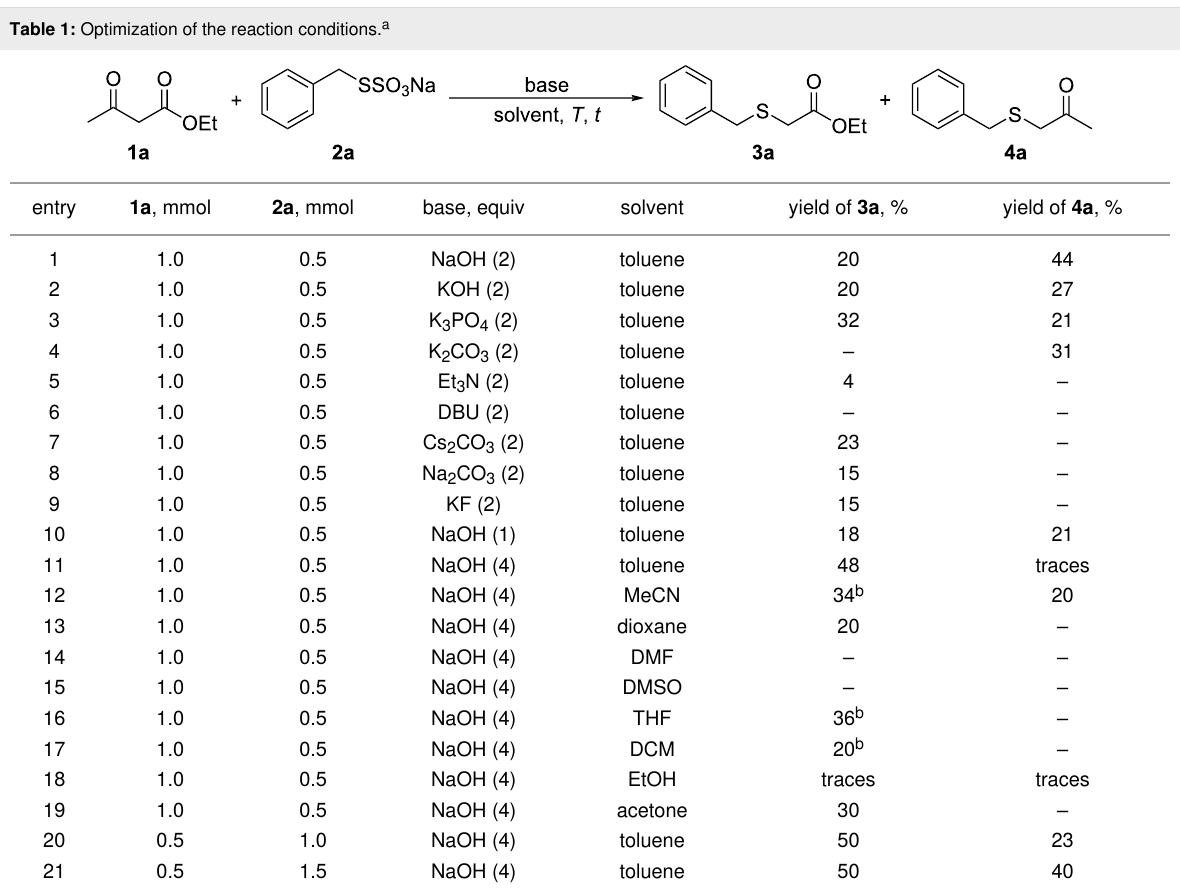
Table 1: Optimization of the reaction conditions.